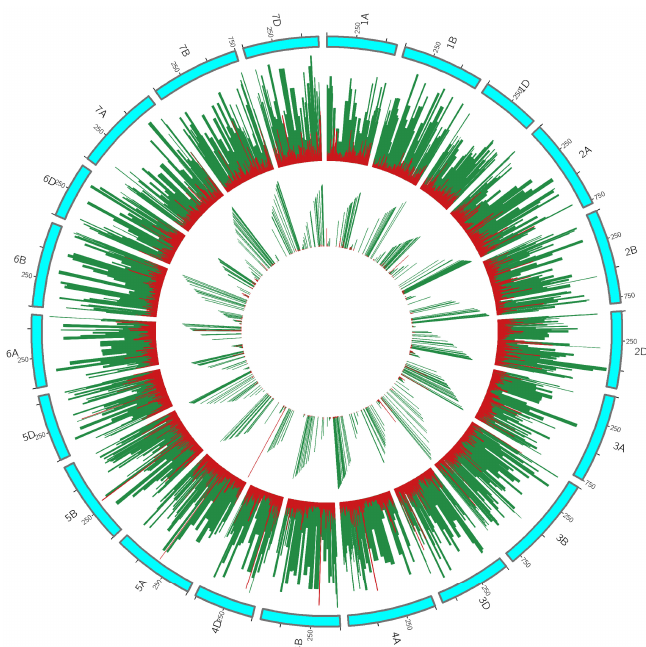
Figure 6. Circos visualization of the RNAseq data at the wheat genome-wide level. From the outer to inner ring; karyotype of the wheat genome; average read depth per million base pair of wheat genome mapping of the resistant (red) and susceptible (green) line; the genomic location of differentially expressed genes for the resistant (red) and susceptible (green) line. Height of bars in outer and inner ring shows the average read depth per million base pair with respect to the genomic location.